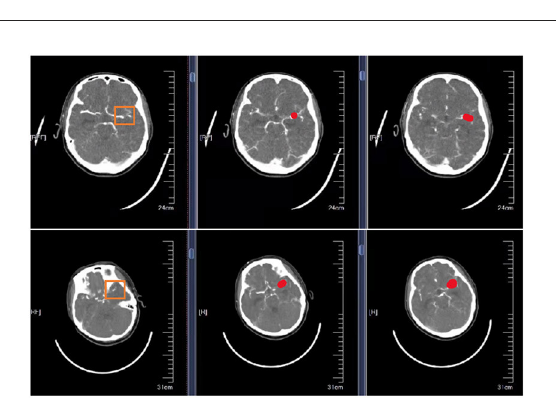
FIGURE5 Schematic representation of correctly segmented cerebral aneurysms at different locations. The first column is the original CTA image. The second column is the result of physician annotation. The third column is the result of physician detection after high-resolution image